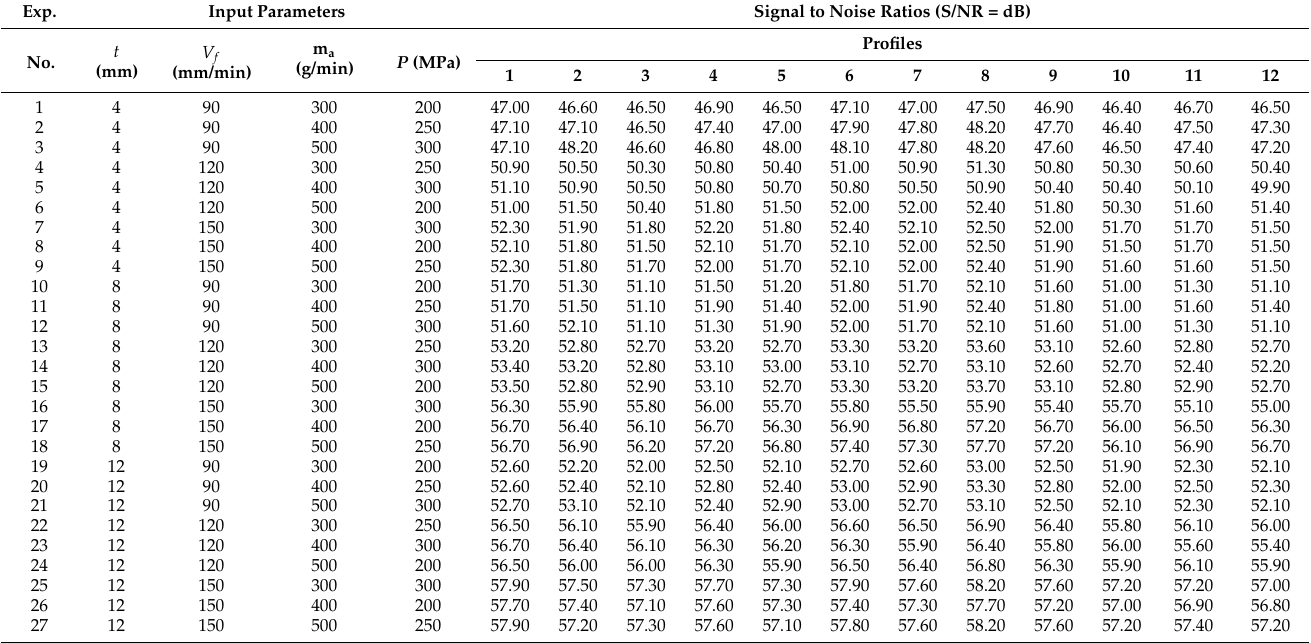
Table A2. Signal-to-noise ratios for material removal rate (larger is better).